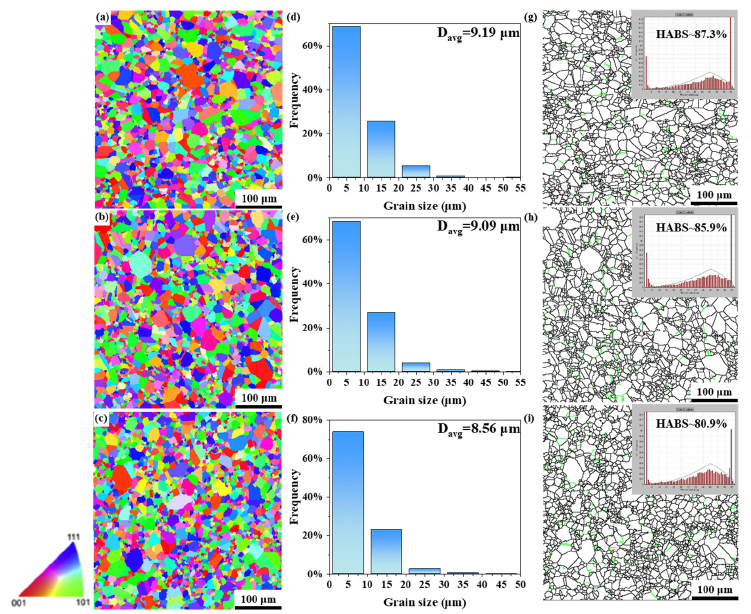
Figure 10. Inverse pole figure and Frequency histogram of grain together with distribution of grain boundary misorientation in as sintered Sc-doped U720Li: ( a , d , g ) 0 wt.% Sc, ( b , e , h ) 0.043 wt.% Sc, ( c , f , i ) 0.066 wt.% Sc. Green lines represent the low angle boundaries (LABs) (0–15°) but the high angle boundaries (HABs) (>15°) were indicated by black lines.